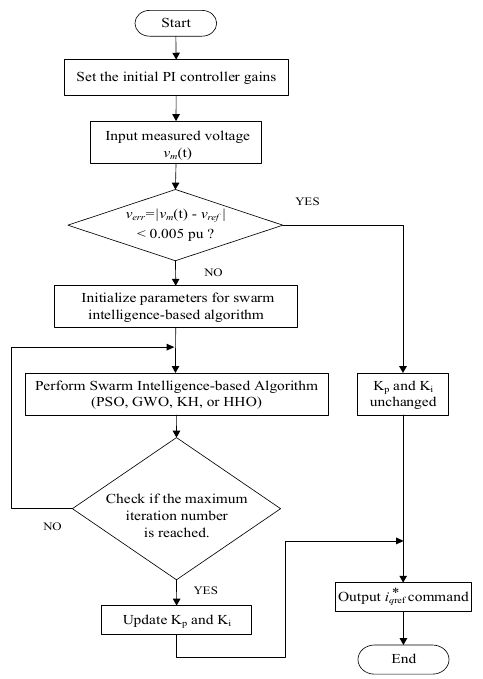
Figure 16. Flowchart of the proposed swarm intelligence-based algorithms for optimizing PI con- troller gains.